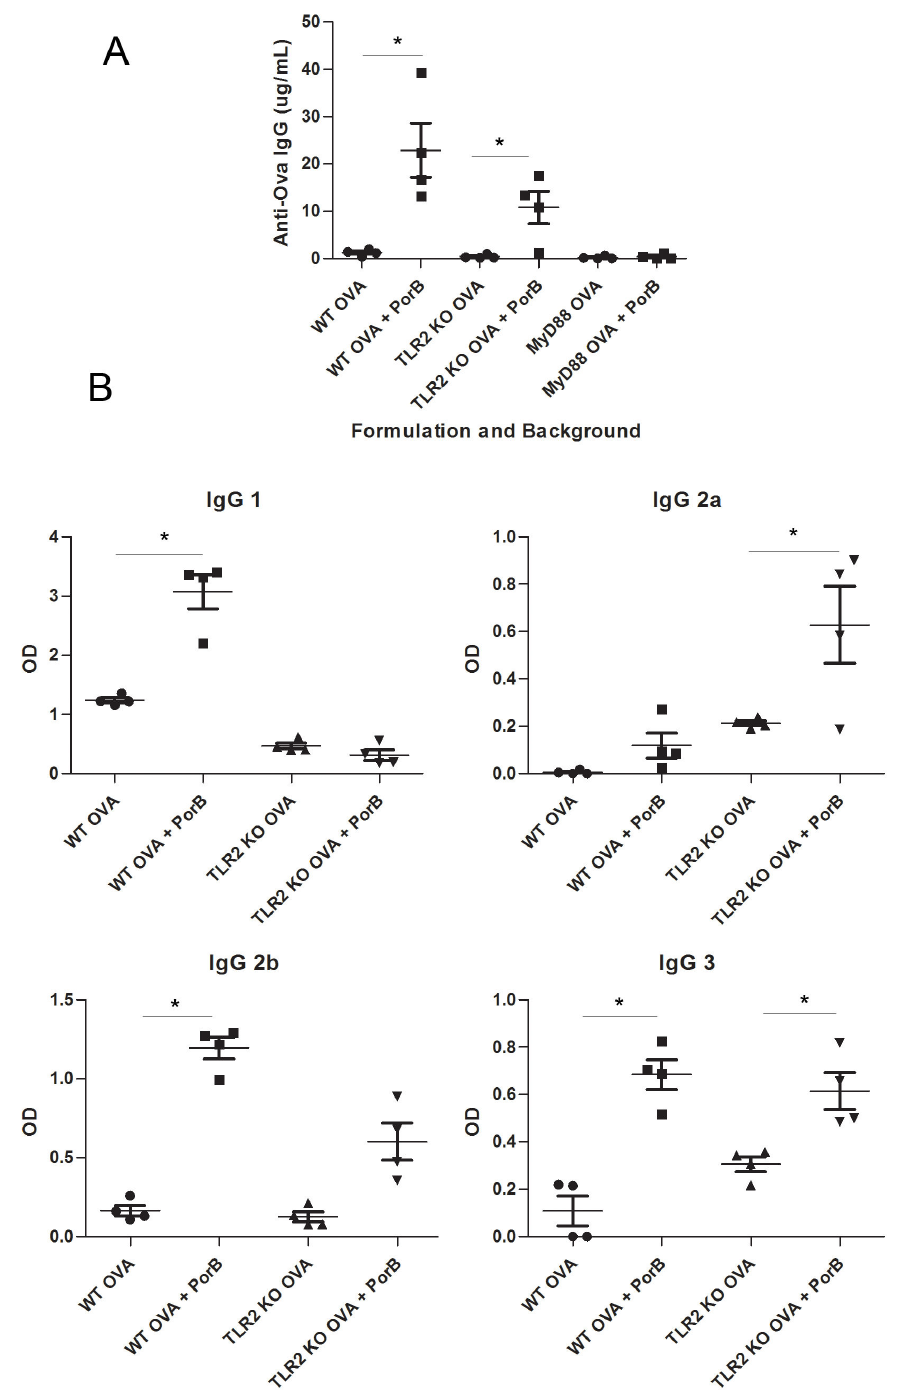
Figure 5. Increases in antigen-specific IgG by PorB is dependent on TLR2 and MyD88. (a) Concentration of IgG antibody to Ova in C57Bl/6 mice as measured by ELISA in serum on from day 42. WT C57Bl/6, TLR2 -/- and MyD88 -/- mice were vaccinated on days 0, 14 and 28 with Ova, Ova + PorB or sham (PBS). Vaccines that included PorB showed significantly less elevation in IgG over vaccines that did not include PorB in TLR2 -/- mice, and no detectable effect in MyD88 -/- mice. None of the mice had detectable antibodies to Ova prior to vaccination (data not shown). (b) OD of specific subtypes of anti-Ova IgG at a 1:50 dilution of serum as measured by ELISA. In WT mice, IgG1 and IgG2b were the dominant subtypes indicative of a Th2-type response. These in turn decreased in the TLR2 -/- mice, consistent with the total IgG data. Data represents one of two experiments. * p<0.05. doi: 10.1371/journal.pone.0082171.g005 PLOS ONE |